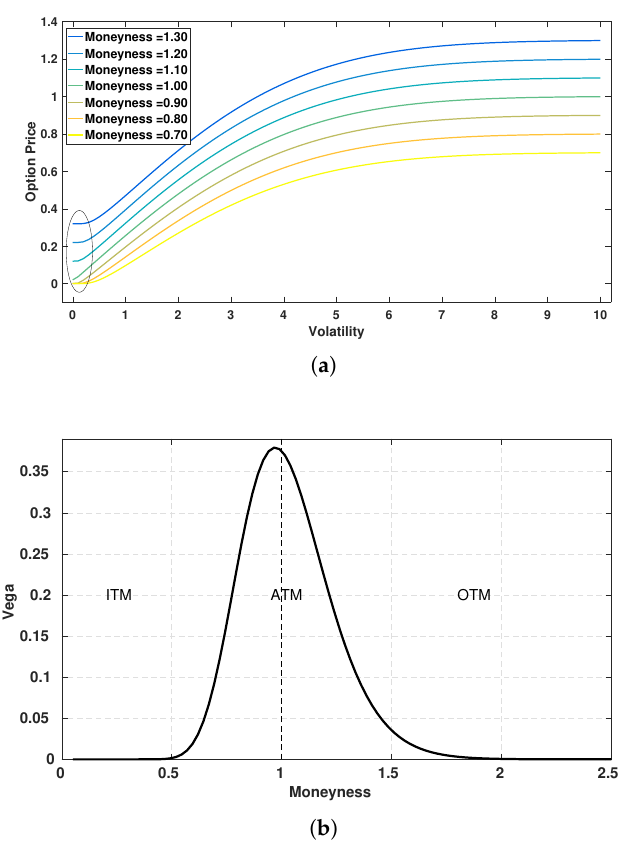
Figure 1. Vega tends to be zero in certain regions of deep ITM or OTM options. ( a ) Option price vs. volatility; ( b ) Vega vs.